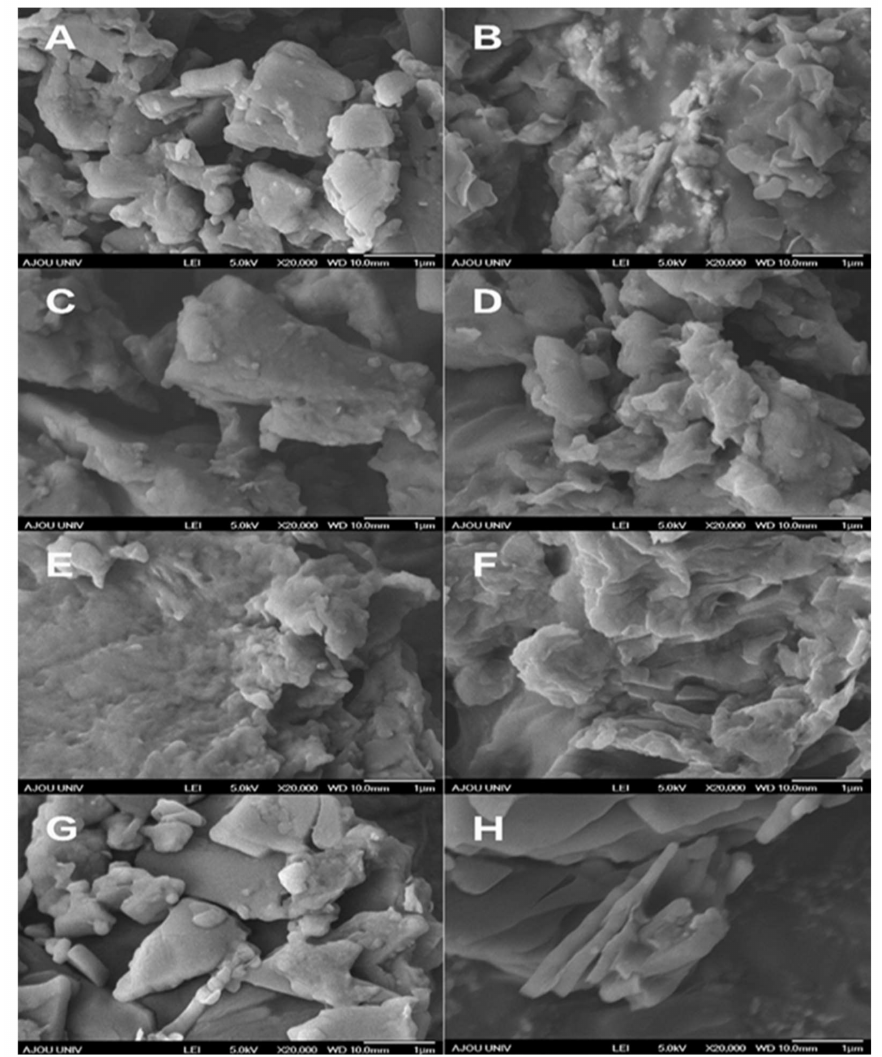
Figure 5. Field-emission scanning electron microscopy morphology of ( A ) pure cilostazol (CLT), ( B )